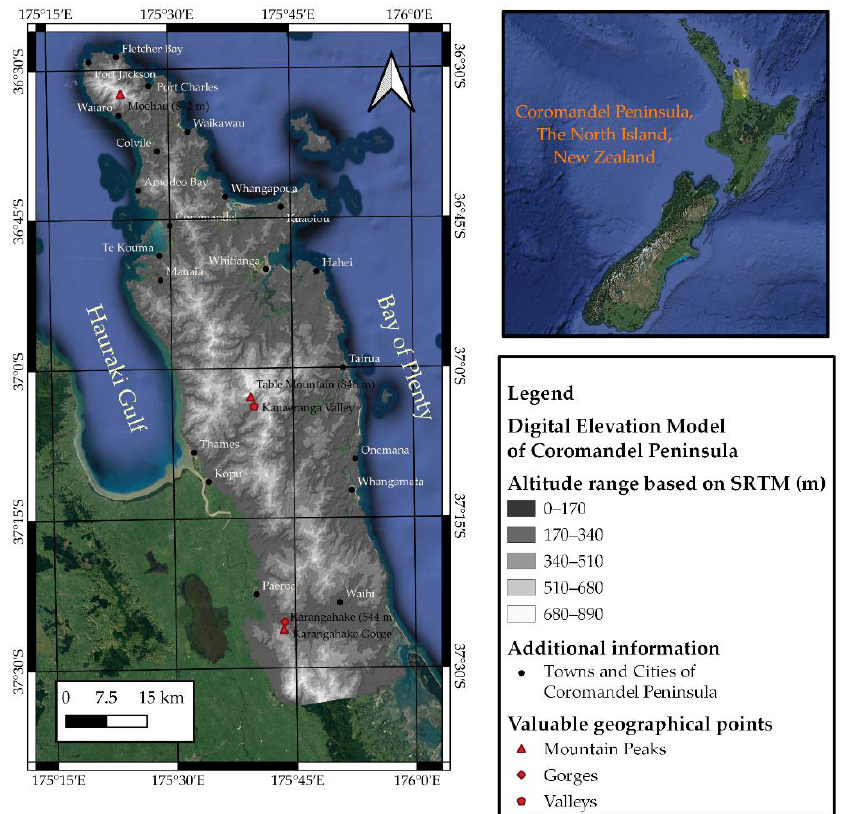
Figure 1. Overview map and elevation model of Coromandel Peninsula created from Shuttle Radar Topography Mission (SRTM) 1 Arc-Second Global (https://www.usgs.gov/centers/eros/science/usgs-eros-archive-digital-elevation-shuttle-radar-topography-mission-srtm-1, accessed on 27 August 2022); background is Google terrain map. The coordinate system is WGS 84 (EPSG: 4327); the same applies for all other